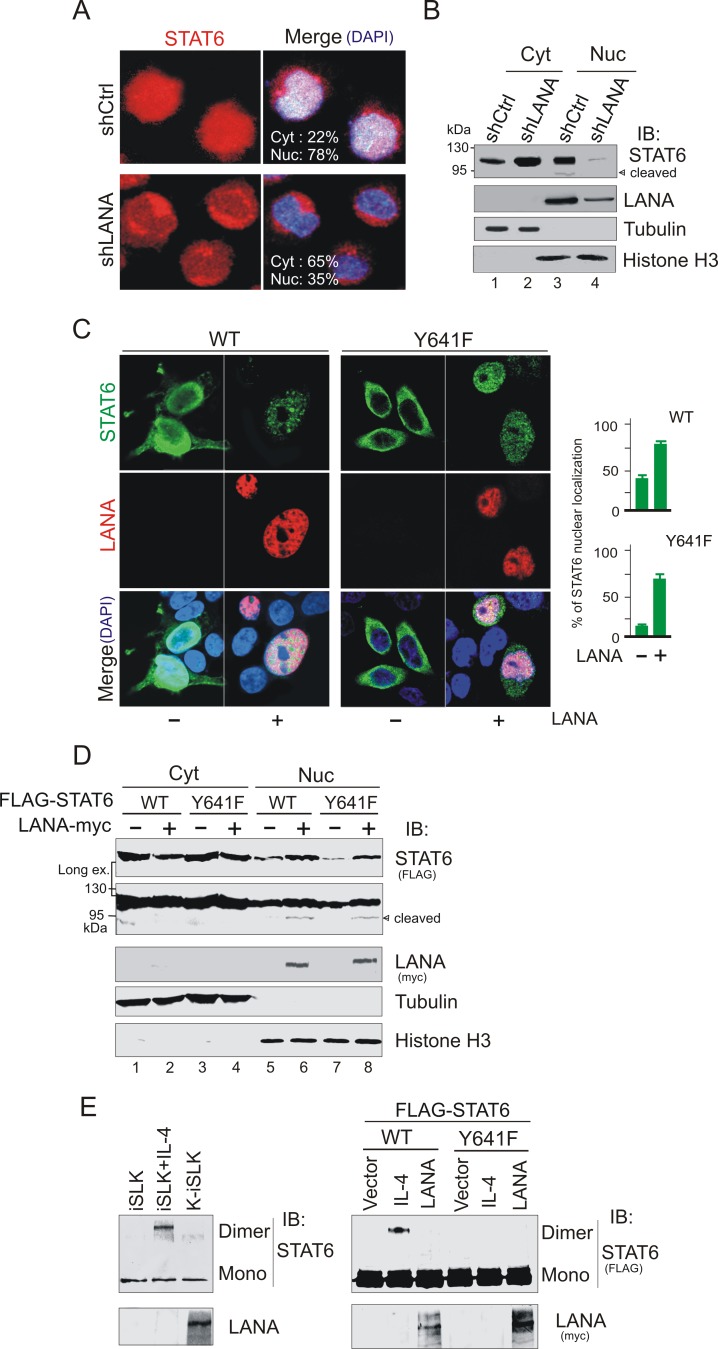
LANA promotes nuclear localization of STAT6 independent of Y641-phosphorylation.(A) Inhibition of LANA blocks nuclear localization of STAT6. Confocal microscopy of endogenous STAT6 (red) and merged in PEL cells BC3 with lentivirus-mediated constitutively knocked down of LANA (shLANA) or luciferase control (shCtrl). Nuclei were stained with DAPI. (B) Western blot analyses of fractionated BC3 cells with LANA or luciferase control knockdown. Cyt, cytosolic; Nuc, nuclear; were revealed by α-tubulin and Histone H3, respectively. (C) LANA induces nuclear localization of exogenous STAT6 independent of phosphorylation on tyrosine 641. HEK293 cells transfected with wild type (WT) or Y641 mutant (Y641F) of STAT6 with FLAG tag (green) in the presence or absence of LANA with RFP tag (red) were imaged by confocal assay. Nuclei were stained with DAPI. The relative percentage of STAT6 nuclear localization (right panel) was individually quantitated by nuclear and cytoplasmic staining of 100 cells. (D) Immunoblotting analyses of fractionated 293 cells transfected with expressing plasmids as indicated. Cyt, cytosolic; Nuc, nuclear; were revealed by α-tubulin and Histone H3, respectively. (E) Cells from panel C in Fig 1 or panel D were individually treated with DSS for 30 minutes before lysis and analyzed by immunoblotting (IB) for dimerization of STAT6 (data is shown on the left and right panels, respectively). Cells treated with IL-4 (50 ng/ml) for 30 min were used as control.